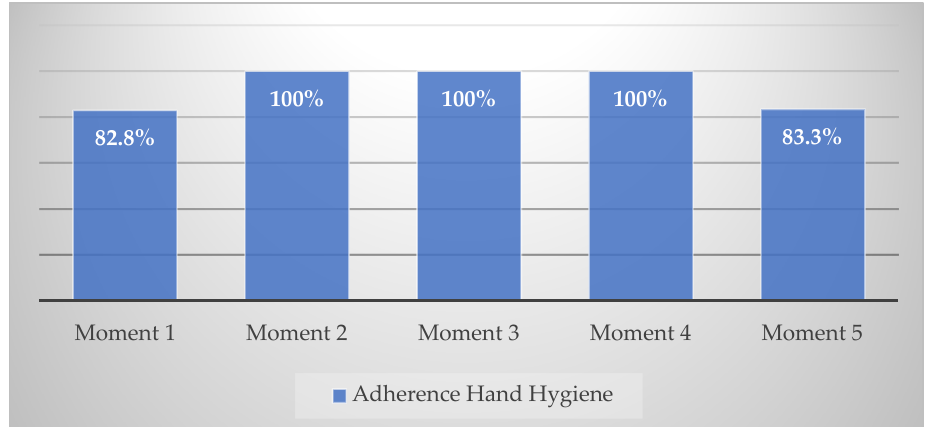
Figure 1. Adherence to the ‘five moments’ for hand hygiene. Nurses preferred using alcohol-based formulation (72.1%) and a smaller percentage chose to wash their hands with plain soap and water (27.9%). Alcohol-based hand rub is, indeed, the gold standard of hand hygiene [6].